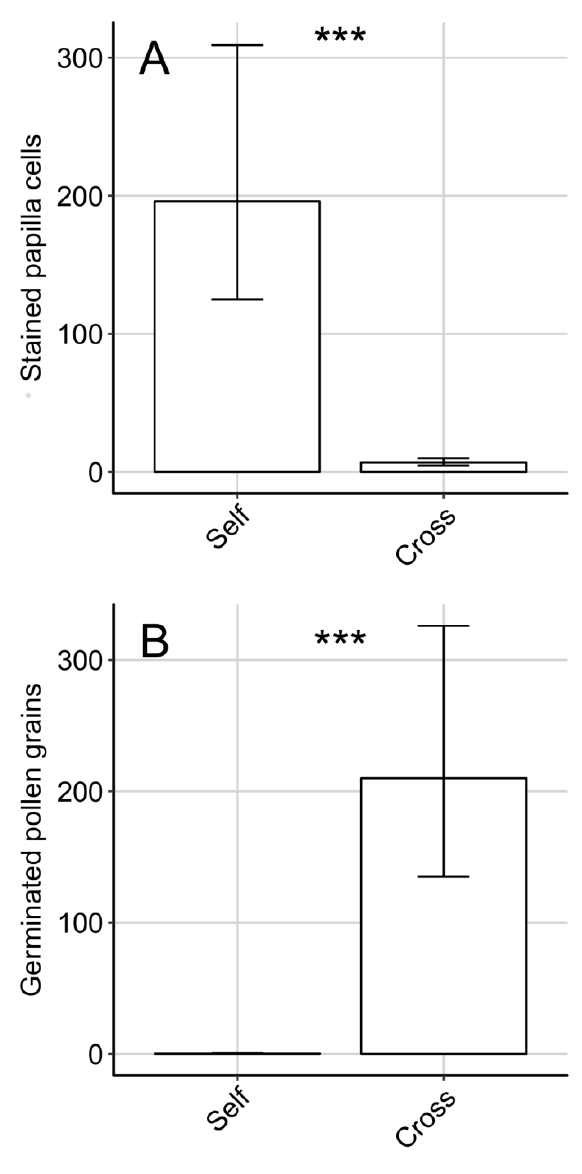
F IGURE 4. Results of manual self- and cross-pollination tests showing that the Brassica rapa plants were self-incompatible, and showing that papilla cells of the stigma stain in response to self- pollen, but not cross-pollen. (A) Pollen germination response to self- and cross-pollen. Germinated pollen grains are those that have produced pollen tubes that penetrate the stigma (i.e. ‘GPG’ in Fig. 2B). (B) Papilla cell response to cross- and self-pollen. An example of the stained papilla cells is shown in Fig. 2D. Asterisks show significance in difference between self- and crosses: ‘***’ = P < 0.001. Estimates (mean ± 1 SE) are produced from final model (see Tab. 1 for statistics and sample